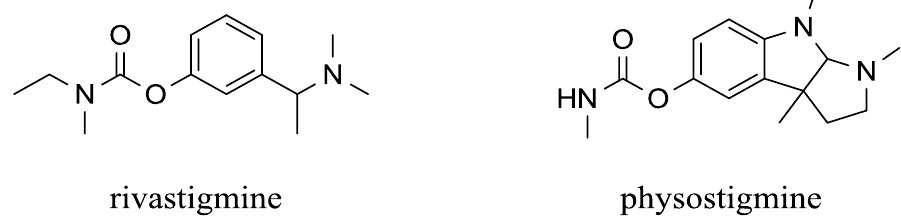
Figure 3. Structure of carbamates that cross the blood brain